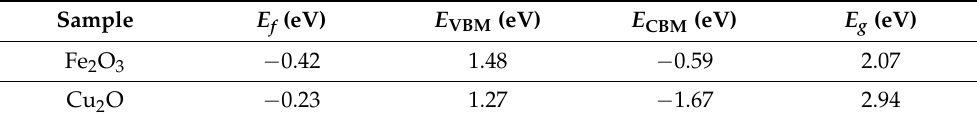
Figure 6. UPS spectrum of ( A ) Ti:Fe 2 O 3 and ( B ) CuAl-LDH/Cu 2 O. Table 2. Fermi level, valence-band maximum (VBM, EVBM), conduction-band minimum (CBM, ECBM), and bandgap energy ( Eg ) (vs. RHE) of Fe 2 O 3 and Cu 2 O.